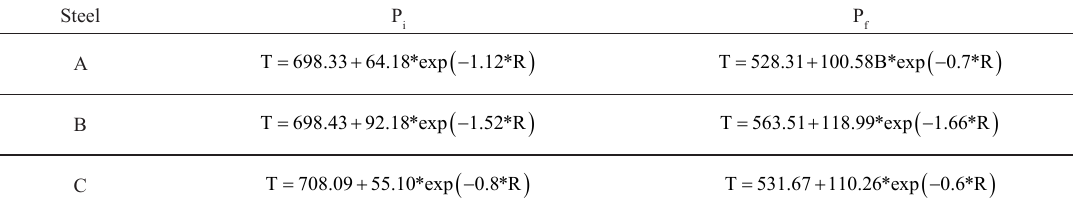
Table 6. Empirical equations predicting critical temperature values as cooling rate functions (Equation 5). Steel